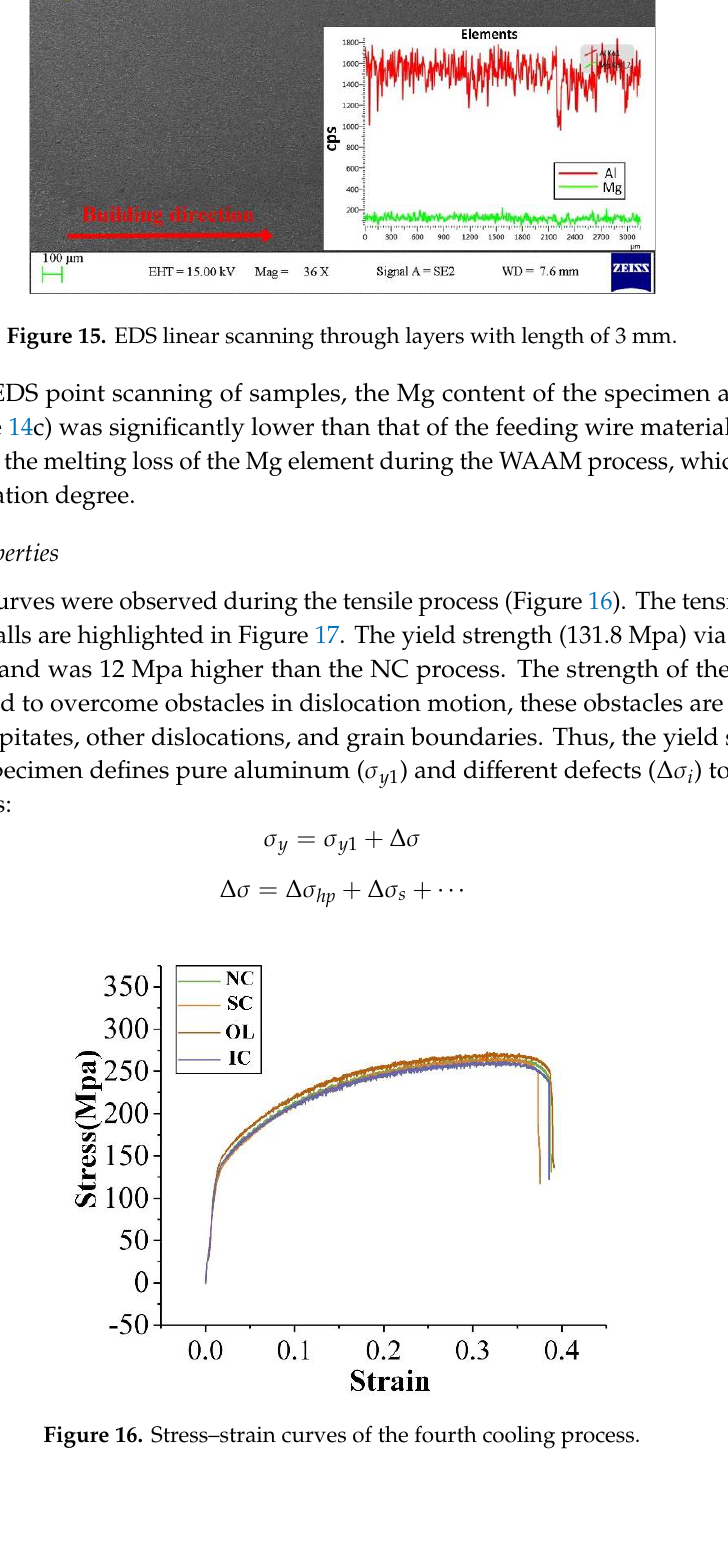
Figure 14. Energy Dispersive Spectrometer (EDS) results of the microstructure characteristics observed via a scanning electron microscope (SEM): ( a ) skeletal structure; ( b ) feeding wire; ( c ) specimen by NC process.